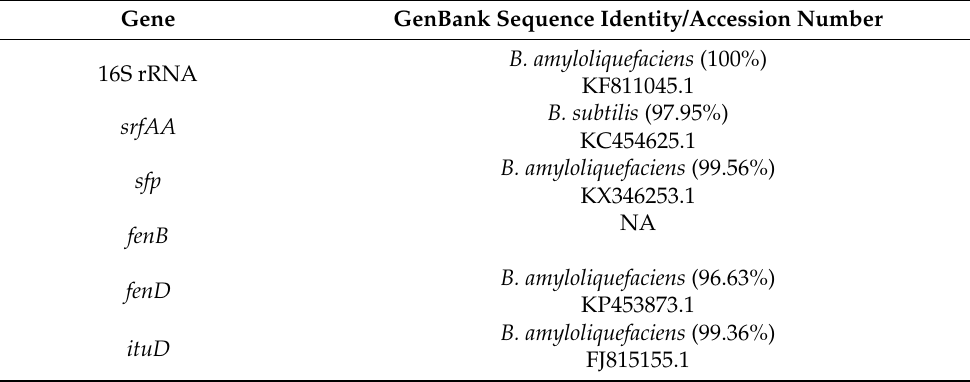
Table 1. Results of BLASTn analysis of 16S rRNA and BS genes of B. amyloliquefaciens 3/22.